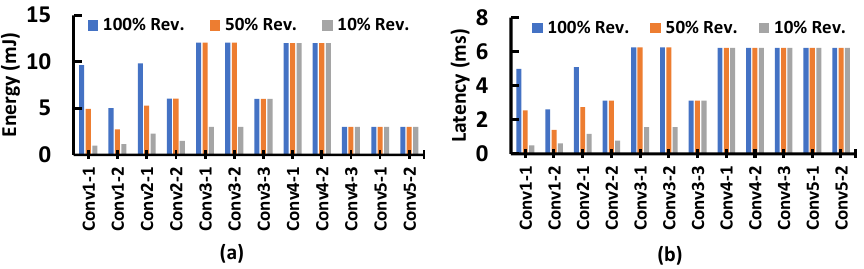
Figure 13. ( a ) Energy consumption at the different stages in the processing hierarchy. ( b ) Time required to perform computation at every stage for the VGG-16 model. The analysis is made under three different 100%, 50%, and 10% relevant